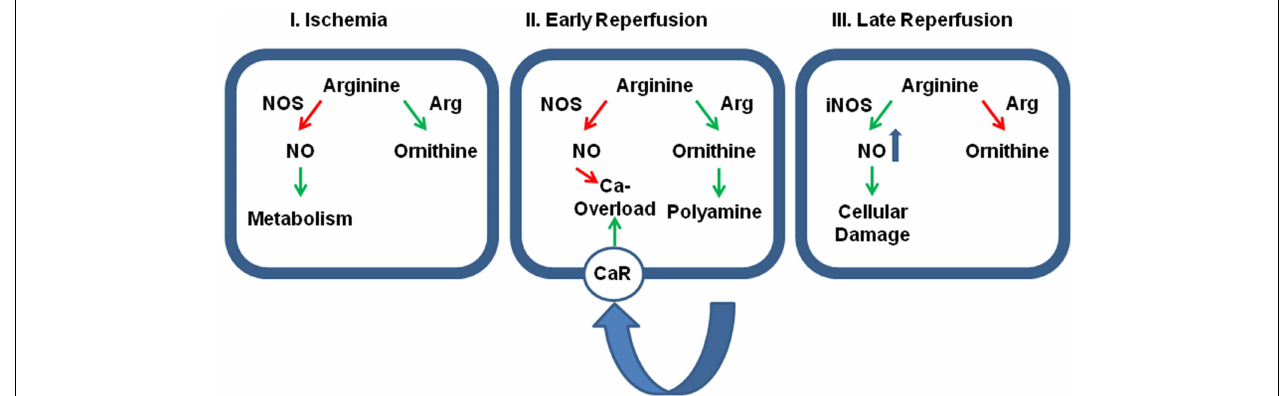
FIGURE 2 | Relative contribution of cellular protection vs. cellular damage of the two main arginine pathways. Panel (I) : During ischemia the activation of arginase (Arg) activity reduces the effect of physiological levels of NO on cellular metabolism thereby and reduces otherwise accumulating arginine levels. At this time, inhibition of arginase would be detrimental for the outcome. Panel (II) : During early reperfusion, dominance of arginine pathway limits the protective role of NO, specifically on SR-calcium load that triggers fatal arrhythmic events. Moreover, the activated